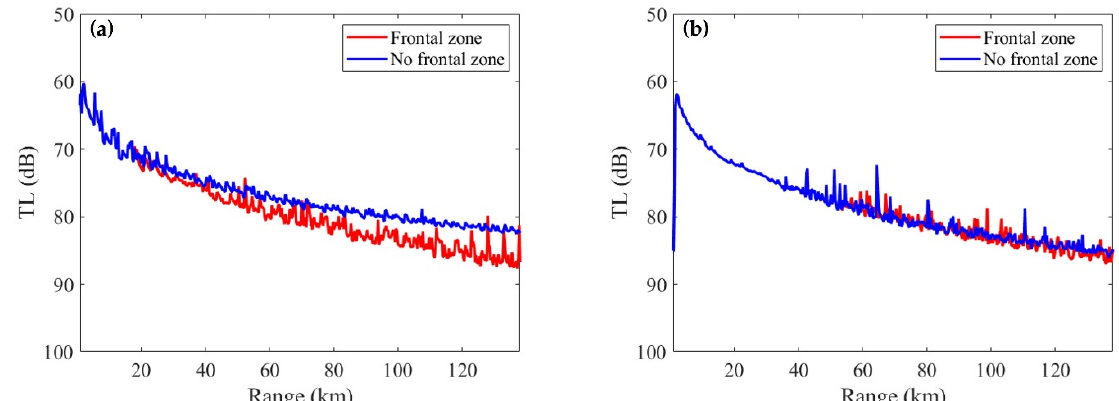
Figure 5. The comparison of the TL between the existing frontal zone and none at different depth range and different directions at the 39.5° W section: ( a ) 0–200 m, the direction is 50.6°–51.6° N; ( b ) 200–400 m, the direction is 51.6°–50.6° N. The position when the difference exceeds 0.2 dB is used as the criterion for judging the starting point of the frontal zone, and the above two values are 17.9 km and 77.2 km, respectively, the errors between the results of the K-means and the calculation of the TL are more than twice the distance between the two sound speed profiles (11.2 km). It is necessary to divide each layer into two layers evenly, respectively, use the K-means algorithm to cluster the SSP, and then verify the accuracy of the new results.